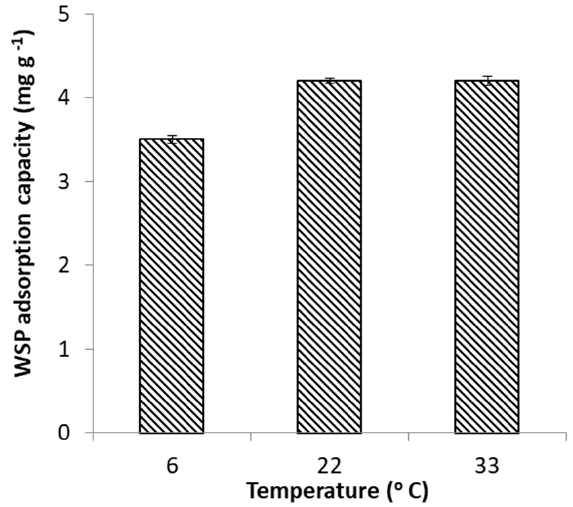
Figure 6. Effect of temperature on Fe II adsorption capacity of WSP.